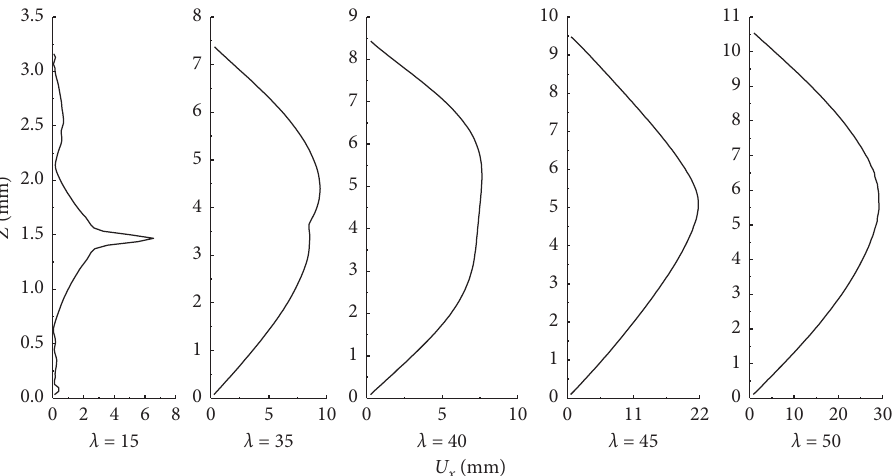
Figure 17: Failure mode (corresponding to P5) of D610 × 8 with different slenderness.